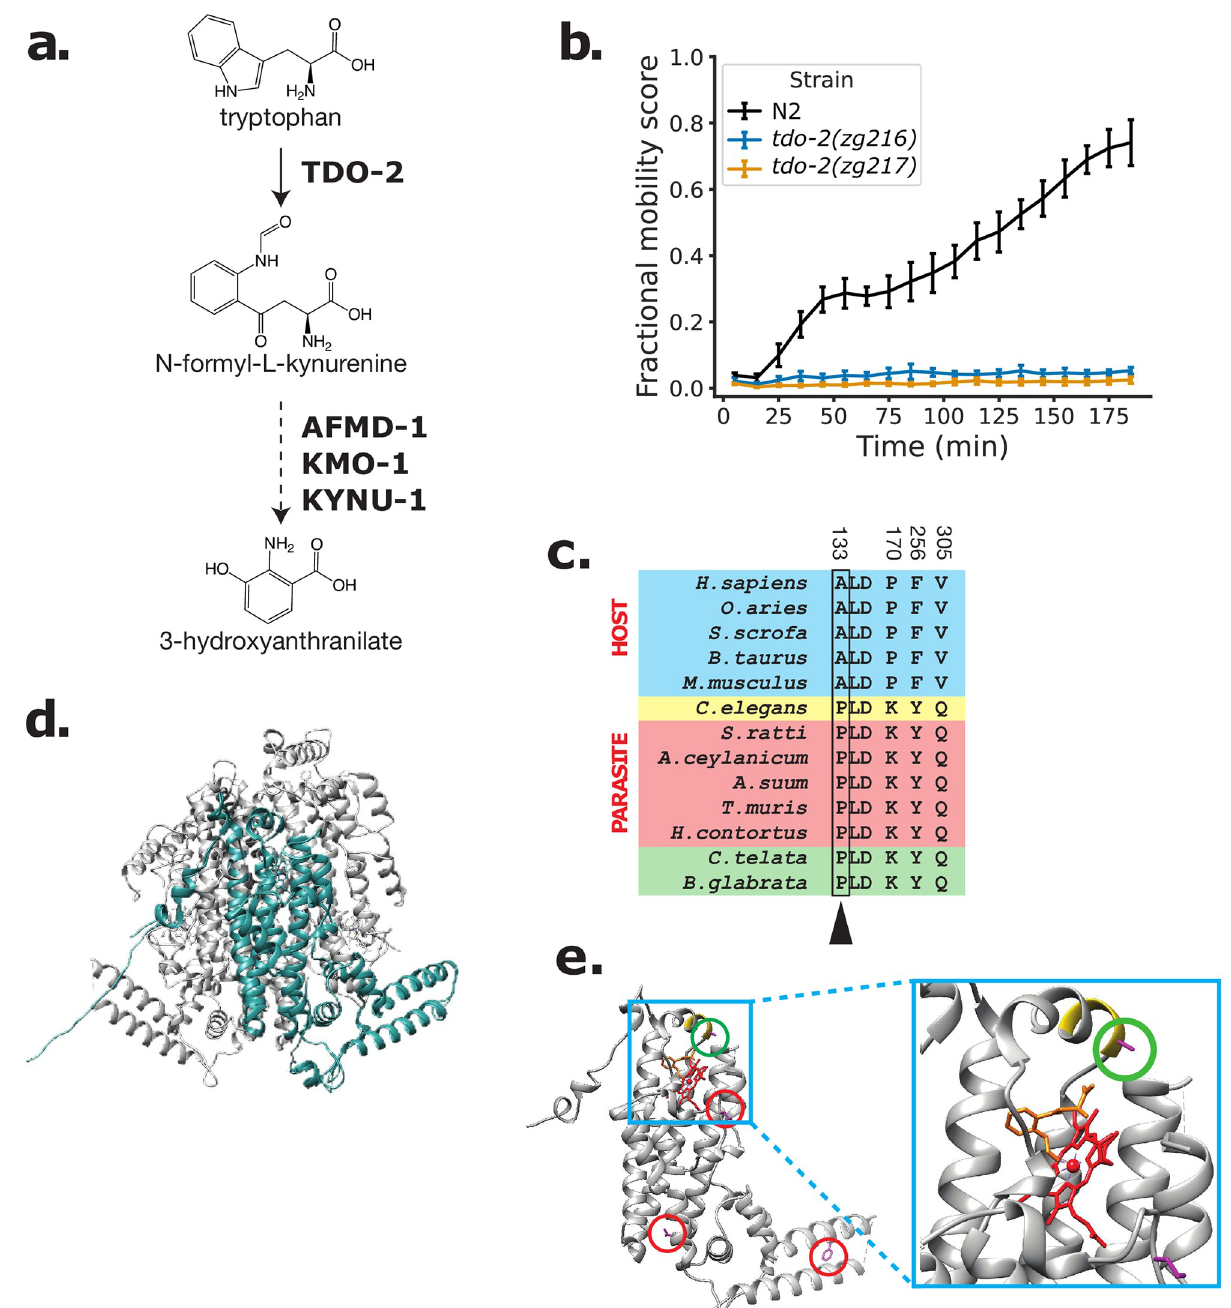
Fig 3. TDO-2 is required for RQ-dependent metabolism. (a) Schematic of kynurenine pathway. 3-hydroxyanthranilate (3HA), a precursor for RQ synthesis, is derived from tryptophan. Tryptophan 2,3-Dioxygenase (TDO; TDO-2 in C . elegans ) is required for the oxidation of L-tryptophan to N- formyl-L-kynurenine while AMFD-1, KMO-1, and KYNU-1 function downstream and were previously shown to be required for RQ synthesis. (b) Wild-type and tdo-2 loss-of-function mutants were treated with 200 μ M KCN for 15 h followed by a 6-fold dilution with M9. Curves show the recovery from KCN treatment and represent the mean of 4 biological replicates and error bars are standard error. (c) Conserved divergent residues from host (blue), C . elegans (yellow), parasite (red) and mollusk/annelids (green) were identified using S3Det [38] with a cutoff of 2 (see Materials and methods). Residues are numbered according to C . elegans . One of the residues (arrow) is part of the PLD loop, a previously identified and evolutionarily conserved structural loop required for enzymatic activity [84]. (d) Crystal model of human TDO (PDB: 5TI9) with the single monomer highlighted in teal as visualized in Chimera [85]. (e) Single monomer of human TDO (PDB: 5TI9) in complex with Tryptophan and dioxygen with C . elegans sequence threaded over by homology (pink residues, circled in red). PLD loop is highlighted in yellow and the A vs P residue is circled in green and is close to tryptophan (orange) and to heme complexed with iron